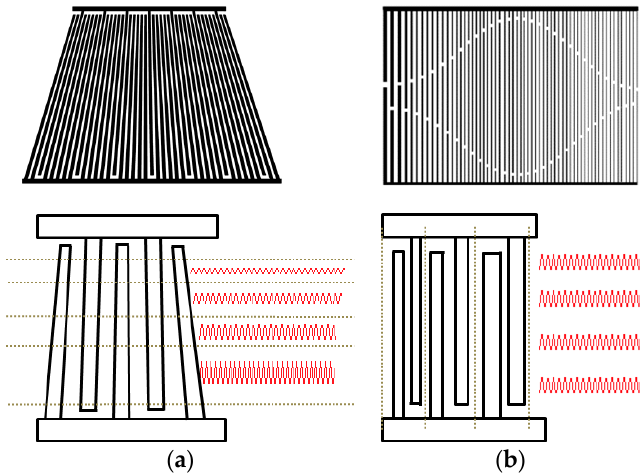
Figure 3. Schematic views of ( a ) slanted IDT ( b ) chirp IDT for COM modeling .